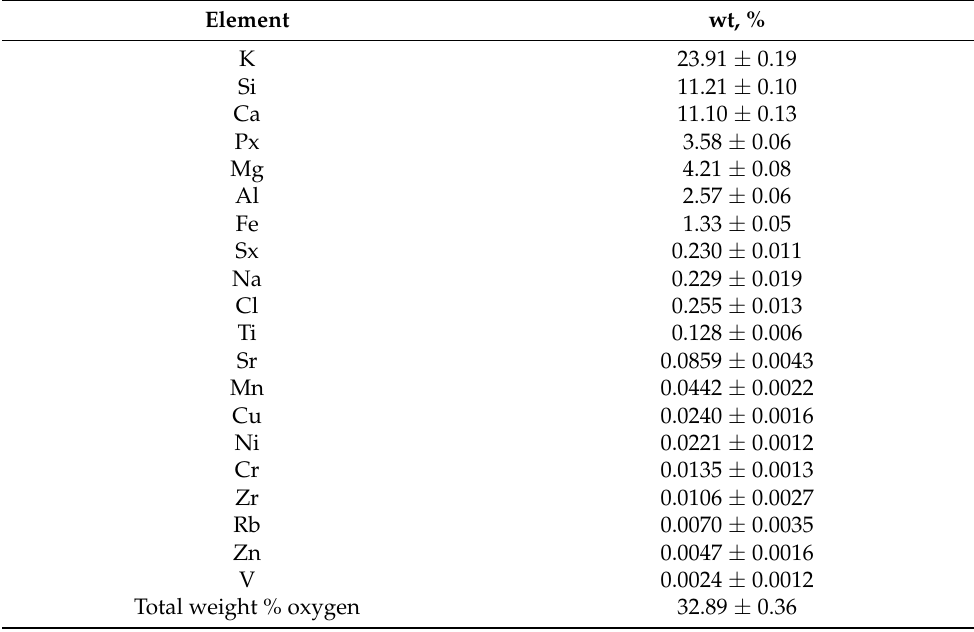
Table 5. X-ray fluorescence of the biomass bottom